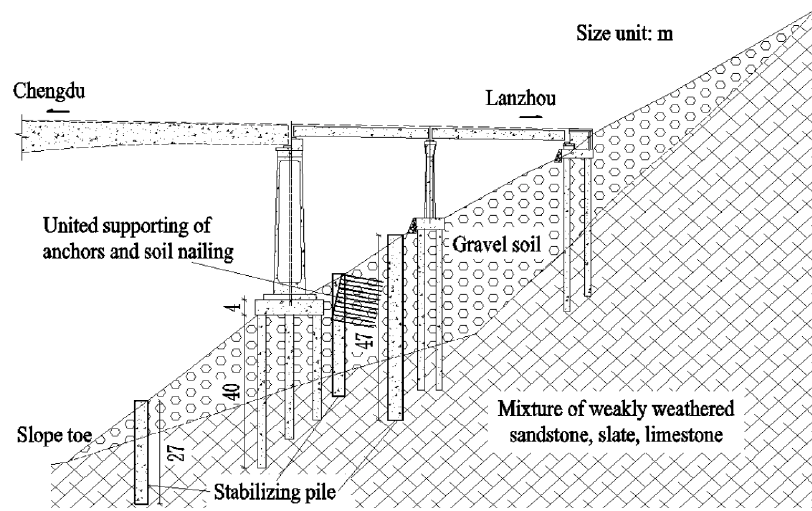
Figure 2. Landslide profile.